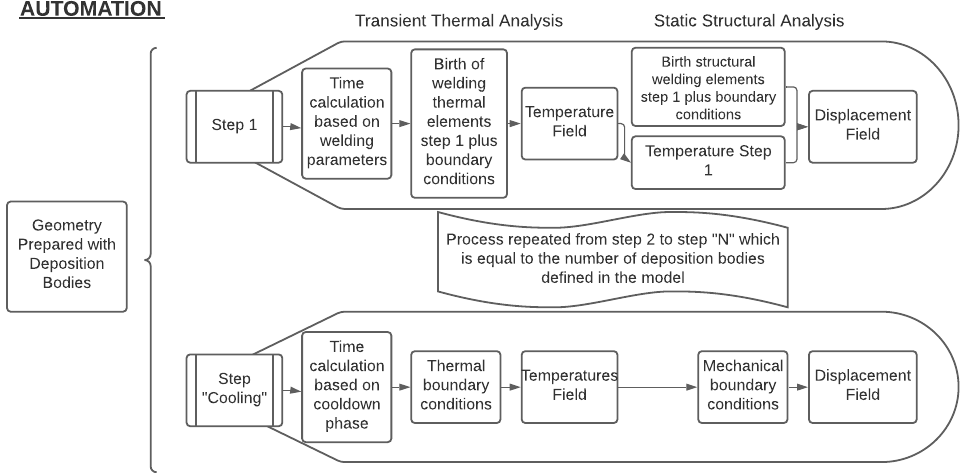
Figure 4. Automatic FE analysis